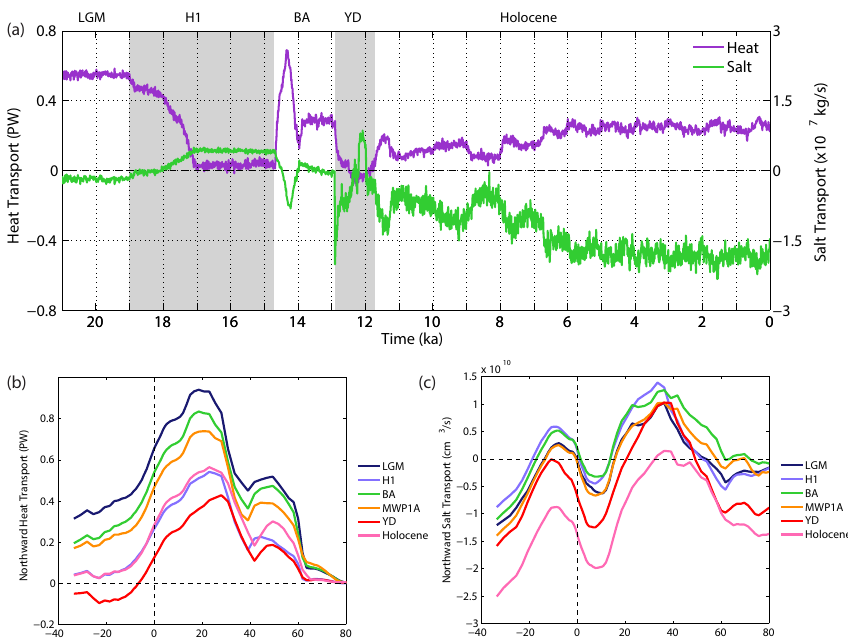
Figure 2. TraCE-21K meridional heat (purple) and salt (green) transport between 30 ◦ S and 0 ◦ (a) . Positive values denote northward trans- port. The main climatic events in the last deglaciation are also marked: Last Glacial Maximum (LGM), Heinrich event 1 (H1), Bølling– Allerød (BA), Younger Dryas (YD) and Holocene. Northward transport of heat (PW) (b) and northward transport of salt (cm 3 s − 1 ) (c) , averaged for each key period when freshwater was injected into the ocean. tropics, centered at 20 ◦ N for the LGM and BA. This max-